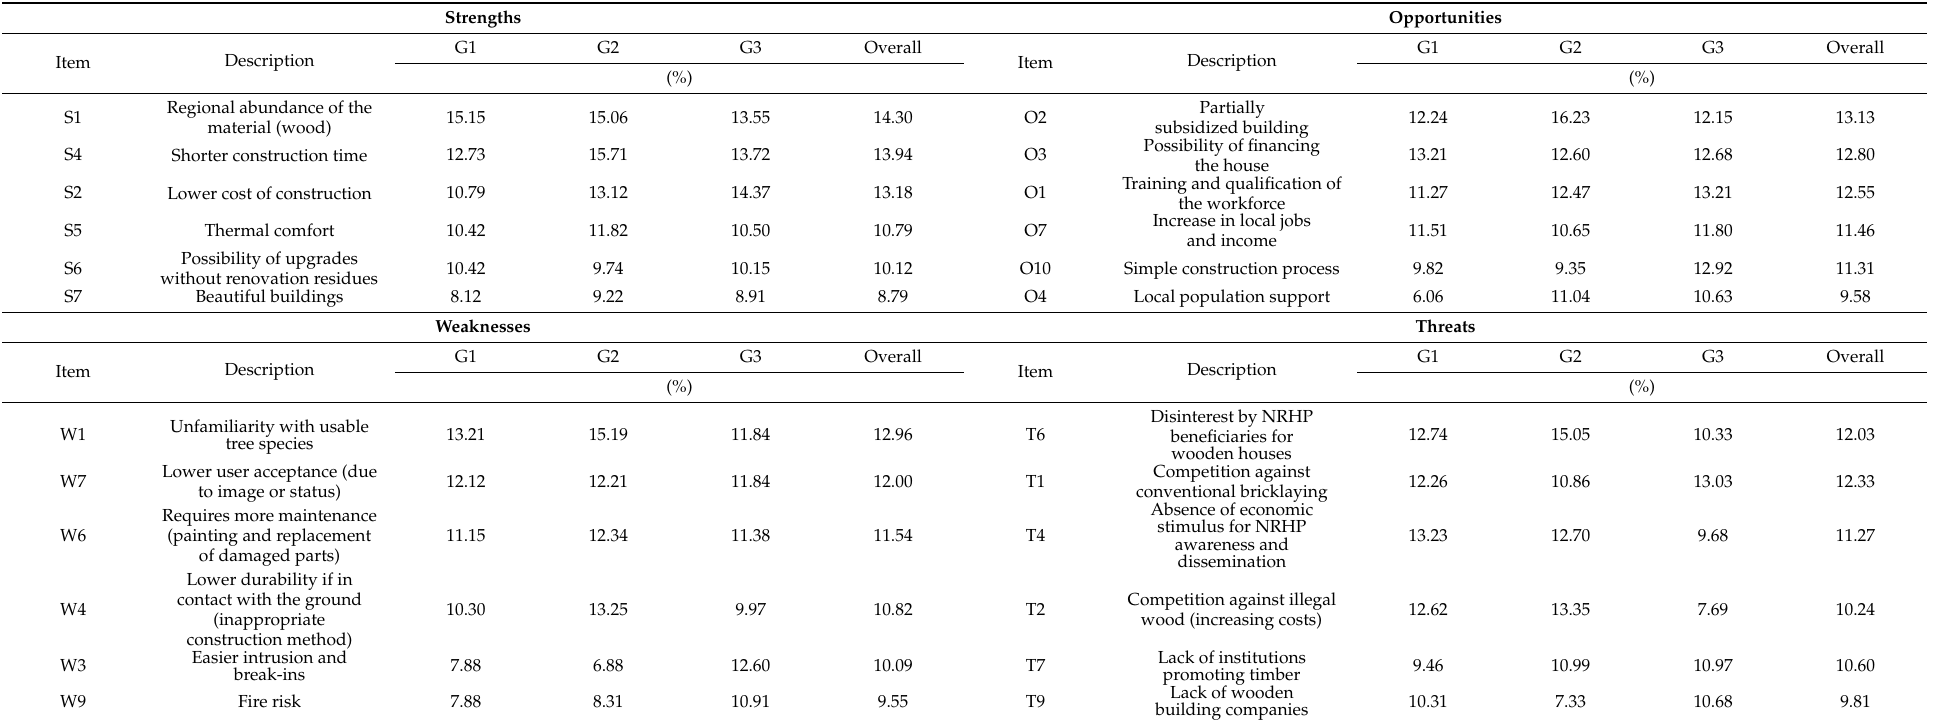
Table 3. Ranking the six variables with the highest